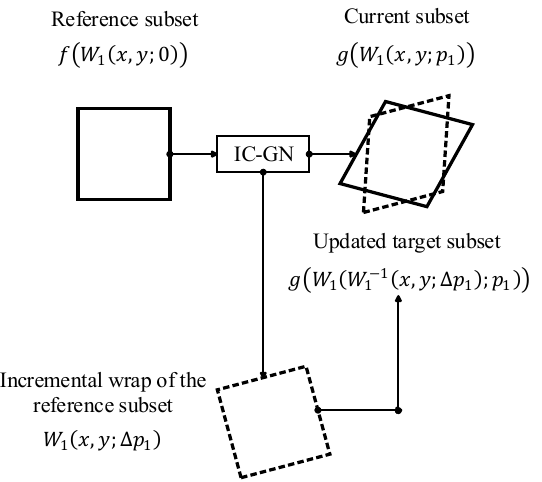
Figure 3. Iteration process of IC-GN method.